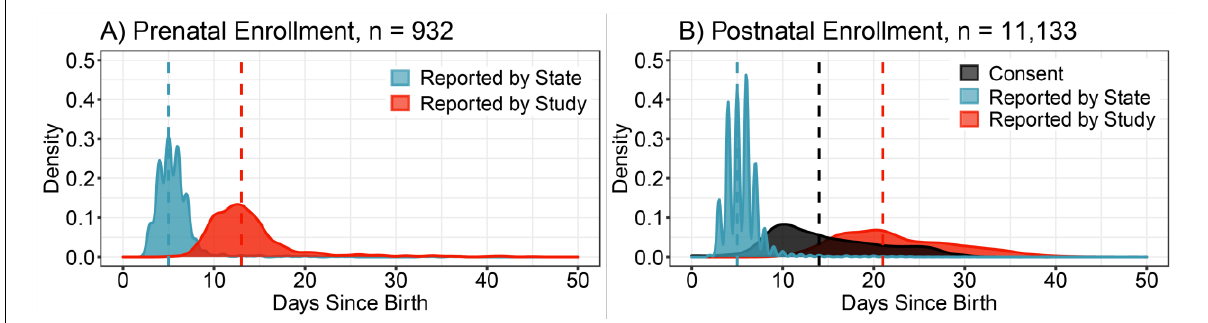
Figure 3. Time to the return of EC results, density plots. Values are given in days post birth. Birth to return of results for ( A ) prenatal ( n = 932) and ( B ) postnatal ( n = 11,133) consents. Birth date enrollments are included in postnatal consents. Vertical dashed lines represent median time post birth for each density plot. NBS results returned by the state (blue, the median for both prenatal and postnatal consents was 5 days). Results returned by EC (red, the median for prenatal and postnatal consents was 13 days and 21 days respectively). Consents obtained by EC (black, the median for prenatal consents was 87 days before birth (not shown) and postnatal consents 14 days after birth).